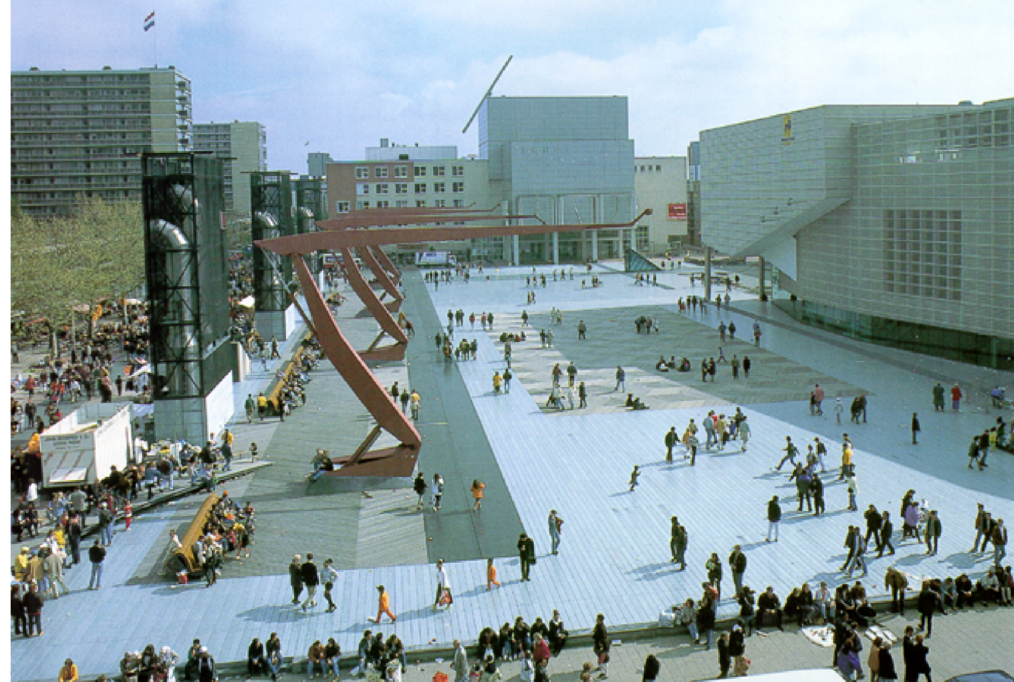
Figure 10. Photograph of the Schouwburgplein with the Lijnbaan ensemble on the left, indicating the identity, continuity and change of the area. Source: Rotterdam Make it Happen